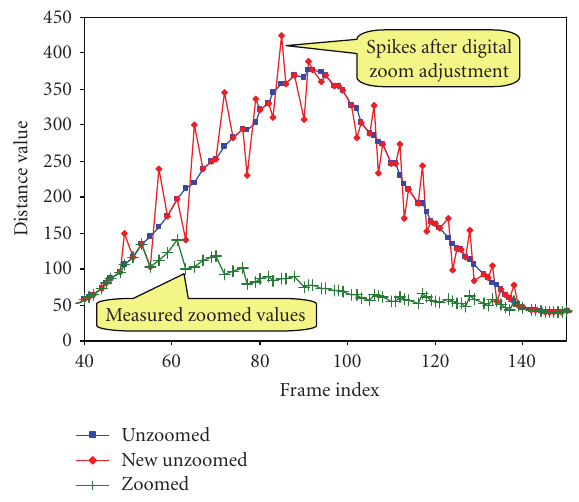
Figure 1: Digital zoom is continuously adjusted. New settings become valid after a delay of a few frames. The unzoomed value is chosen such that the resulting distance curve is smooth.